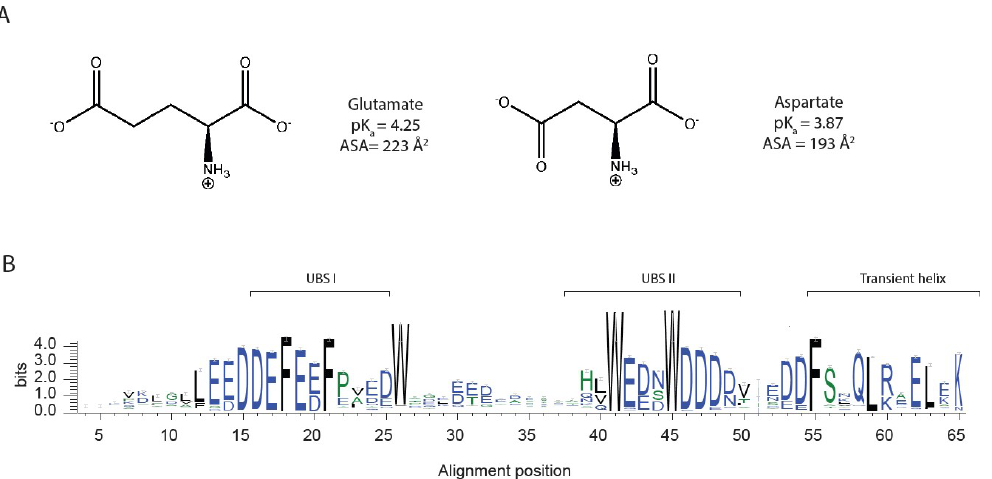
Figure 1. Glutamate and aspartate have similar chemical properties. ( A ) Chemical structure of the amino acids, glutamate and aspartate, ( B ) graphical representation of multiple sequence alignment of the Pfam [17] Dss1/Sem1 family (PF05160), only showing the positions that are present in S. Pombe Dss1, with information content on the y-axis (for the full MSA, see Figure S1). The sequence logo was made using WebLogo 3 [18] .